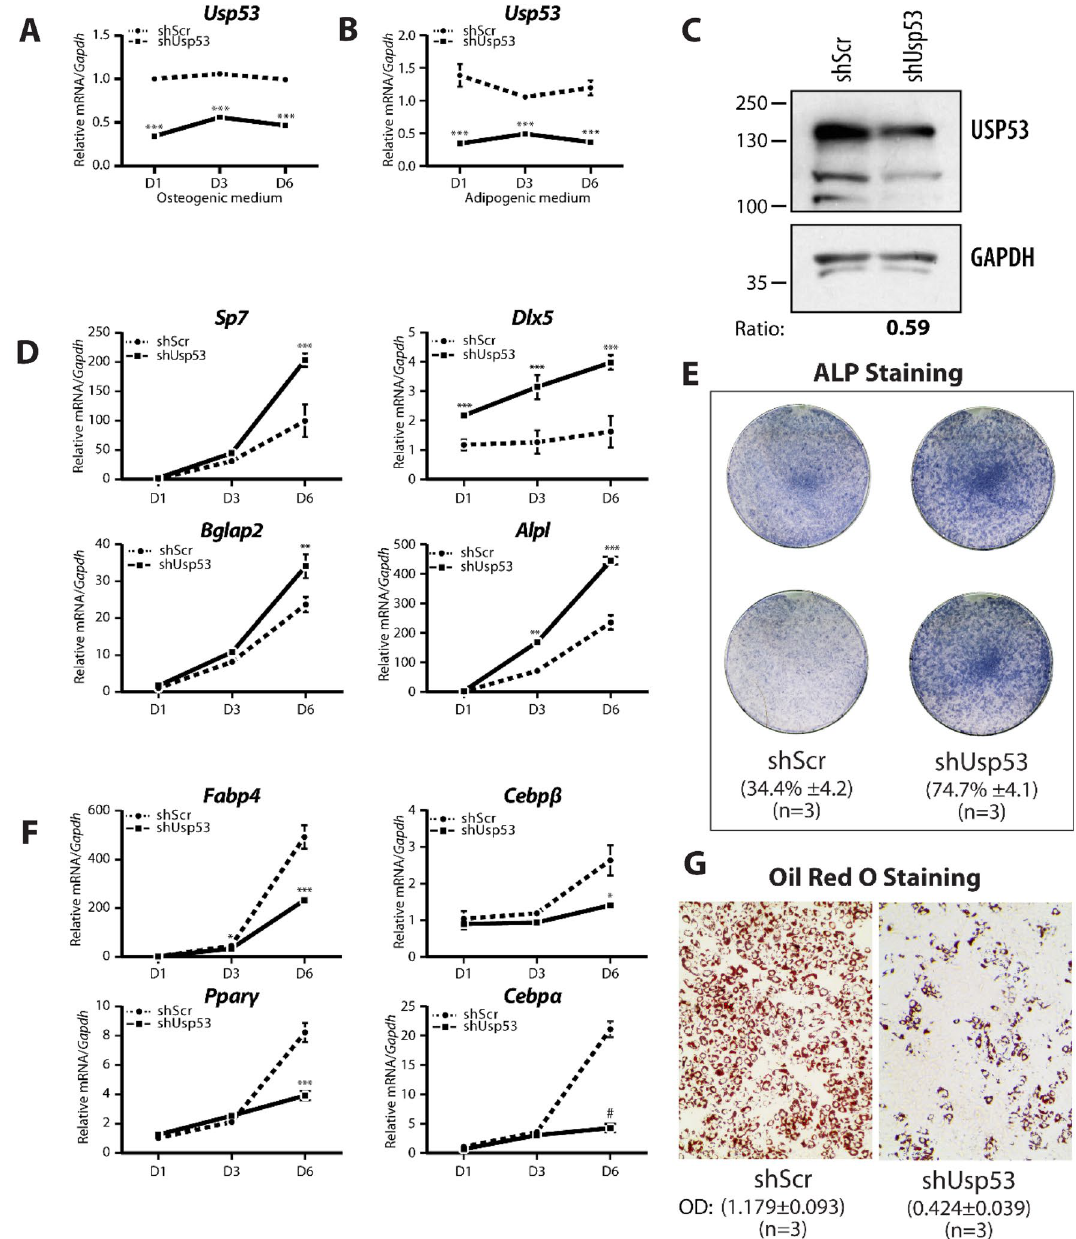
Figure 4. Usp53 controls osteogenic and adipogenic fate determination in vitro . ST2 cells expressing scrambled shRNAs (shScr) targeting control and shRNAs targeting Usp53 were grown under osteogenic conditions ( A ) or adipogenic conditions ( B ) for 6 days. ( C ) Immunoblot of whole cells extracts from ST2 cells stably expressing shRNA targeting Usp53 (shUsp53) and scrambled shRNA (shScr) as control. Membranes were probed with anti-USP53 and anti-GAPDH antibodies (as loading controls). Relative signal intensity quantified using ImageJ is shown below each lane. Full-length blots are presented in Supplementary Figure S5. Gene expression analysis of osteogenic ( D ) or adipogenic ( F ) differentiation markers. Quantitative RT-qPCR using TaqMan probes against osteoblast or adipocyte differentiation markers, normalized to Gapdh , was performed on RNA isolated from shScr-stably transfected (dashed line) or shUsp53-stably transfected (solid line) pools of ST2 cells grown for 6 days in osteogenic or adipogenic medium. ST2 cultures were examined for ALP staining at day 12 ( E ) or oil red O at day 6 ( G ). Results are presented as the mean fold change ± SD. * P ≤ 0.05; ** P ≤ 0.01; *** P ≤ 0.001; # P < 0.0001; ANOVA with Bonferroni’s post-hoc test for all